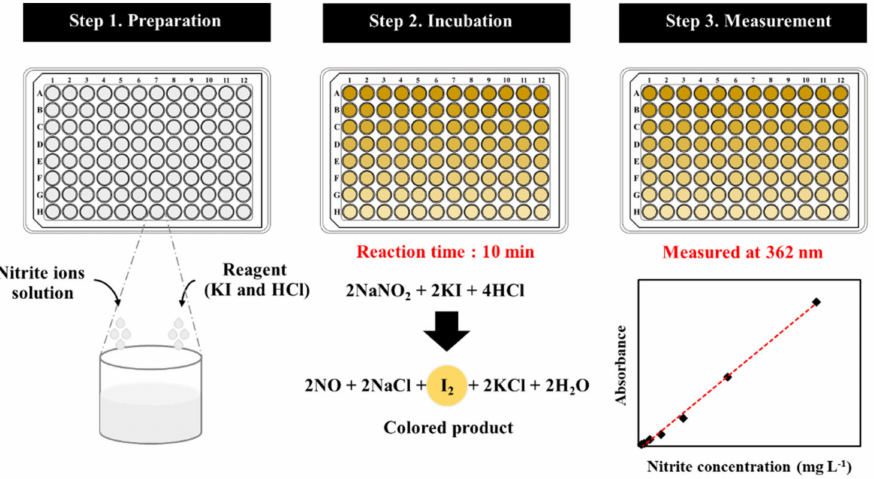
Figure 1. The scheme for the detection of